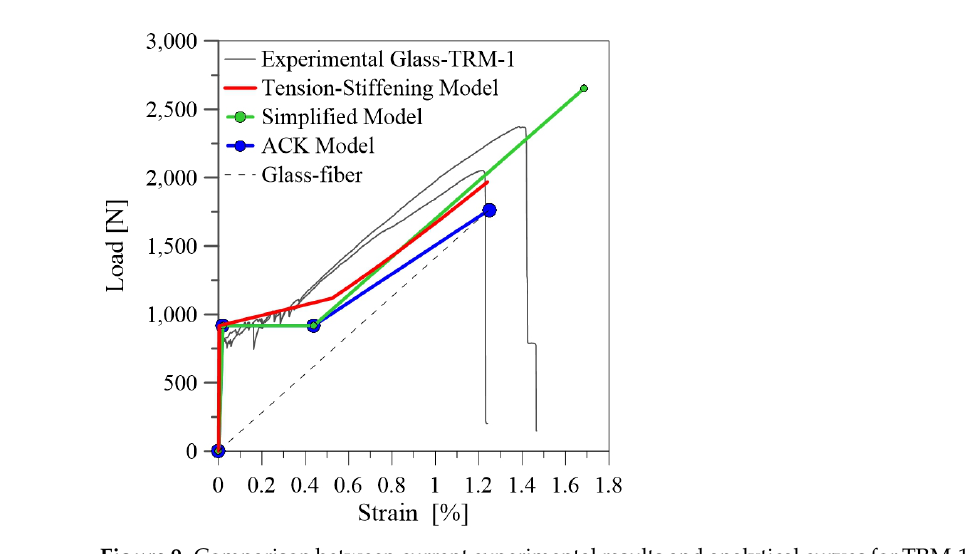
Figure 9. Comparison between current experimental results and analytical curves for TRM-1 specimens.